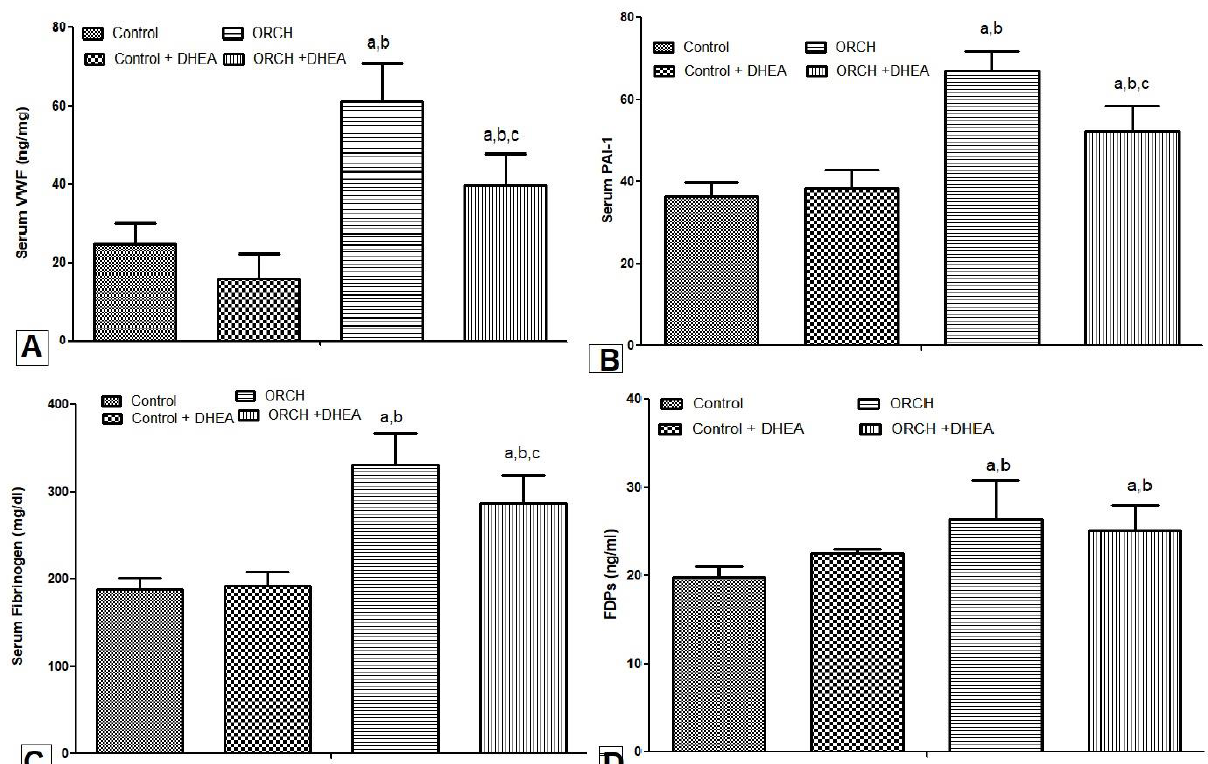
Figure 3. Effect of DHEA on ( A ) serum VWF (Von Willebrand factor) level, ( B ) serum PAI-1 (plasminogen activator in- hibitor-1) level, ( C ) serum fibrinogen level and ( D ) serum FDP (fibrin degradation product) level in orchidectomized rats. a : significance relative to control group, b : significance relative to Con + DHEA group, c : significance relative to ORCH. ORCH = orchidectomized rats and DHEA = dehydroepiandrosterone.